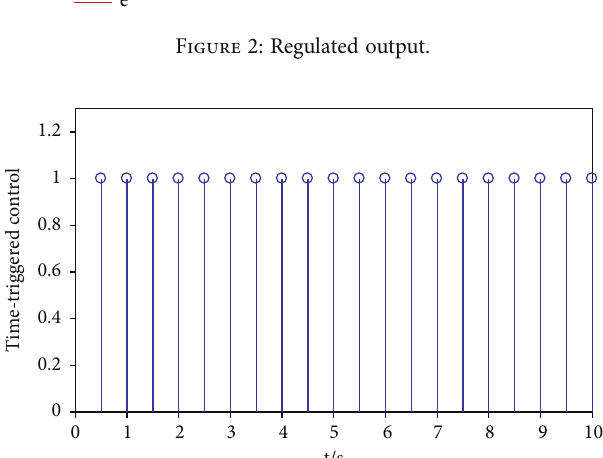
Figure 2: Regulated output.